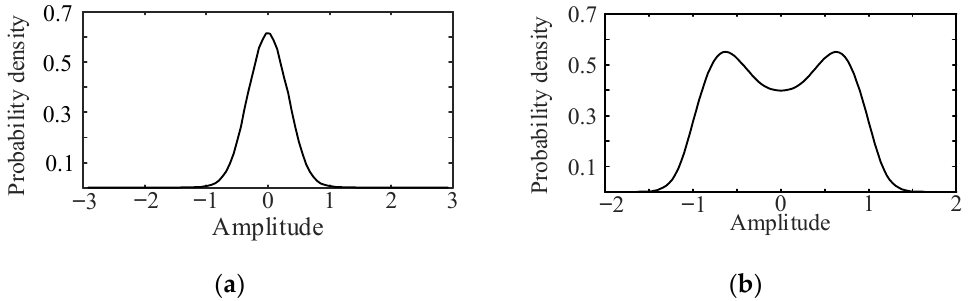
Figure 7. Probability density curve: ( a ) Stochastic response; ( b ) Harmonic response.